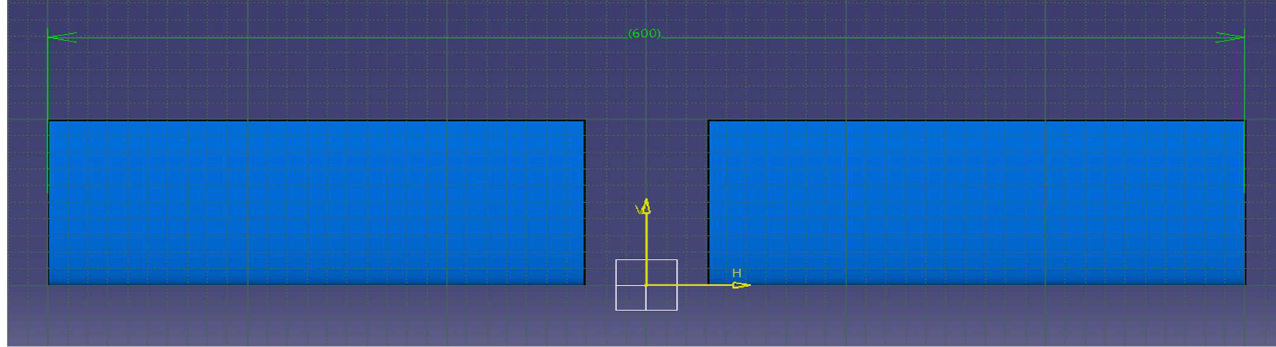
Figure 3. A typical top view of the imposed rectangular wing.